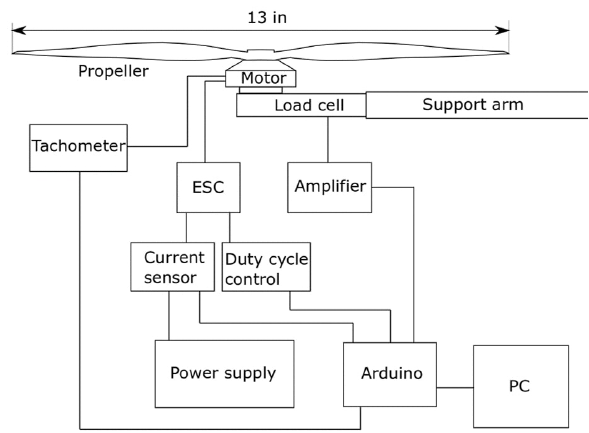
Figure 2. Line diagram showing the different components of the experimental